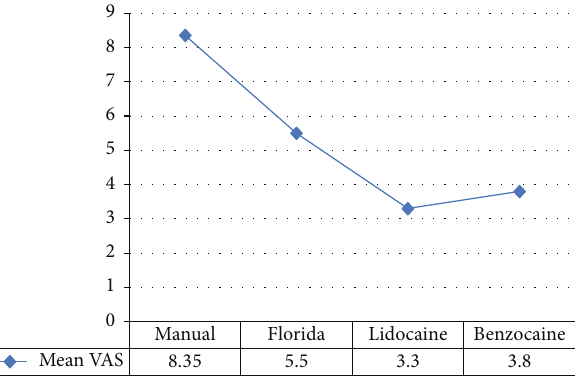
Figure 6: Graphical representation of mean VAS